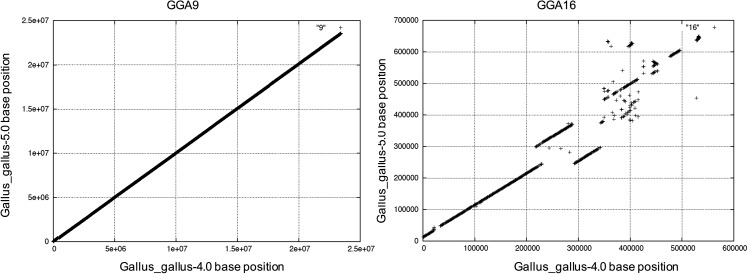
Chromosome synteny alignments of GGA9 and GGA16 derived from Gallus_gallus-4.0 and Gallus_gallus-5.0. Each assembly chromosome file was aligned by BLAT to the other in 1 kb blocks, then parsed by base location.